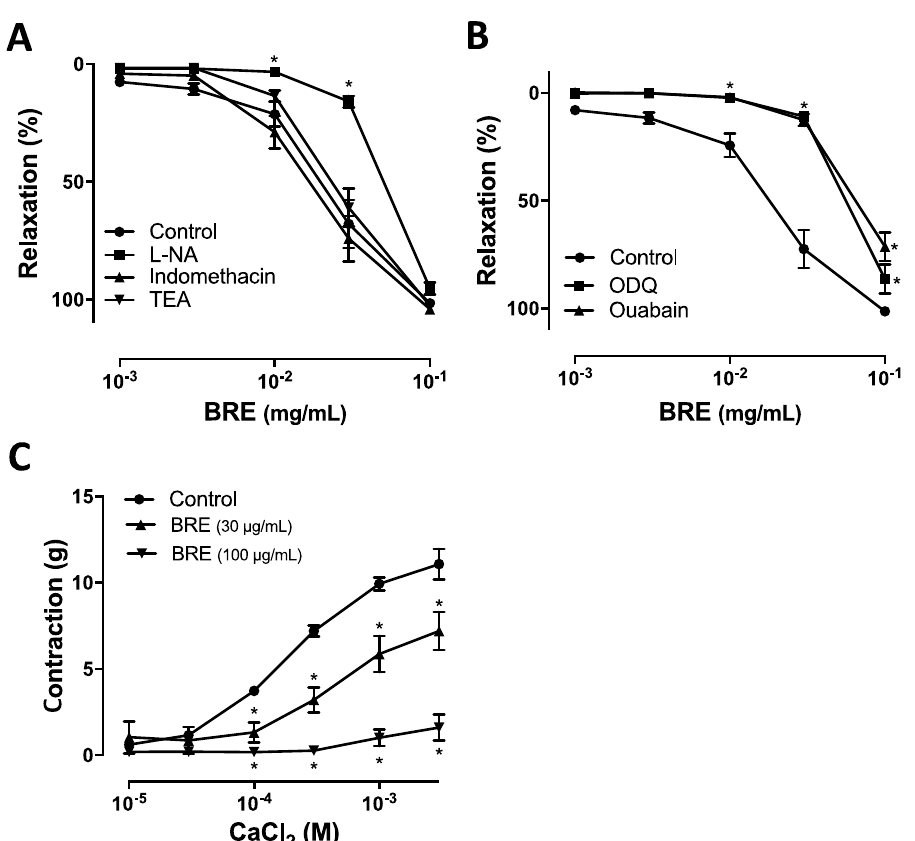
Figure 2. Cumulative concentration–response curves of BRE in coronary artery rings precontracted with U46619 in the presence of ( A ) L-NA (nitric oxide synthase inhibitor, 100 µ M), indomethacin (cyclooxygenase inhibitor, 10 µ M), TEA (non-selective potassium channel blocker) and ( B ) ODQ (guanylyl cyclase inhibitor, 10 µ M), and ouabain (Na + / K + -ATPase inhibitor, 1 µ M). ( C ) BRE inhibits vasoconstriction induced by calcium. Coronary artery rings were treated with BRE at the indicated concentration before drawing a concentration–contraction curve in response to CaCl 2 . Results are shown as mean ± SEM of 5–10 experiments. * p < 0.05 versus control.